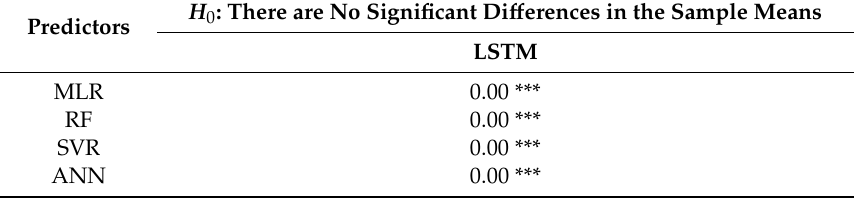
Table 3. Wilcoxon signed-rank test results on prediction